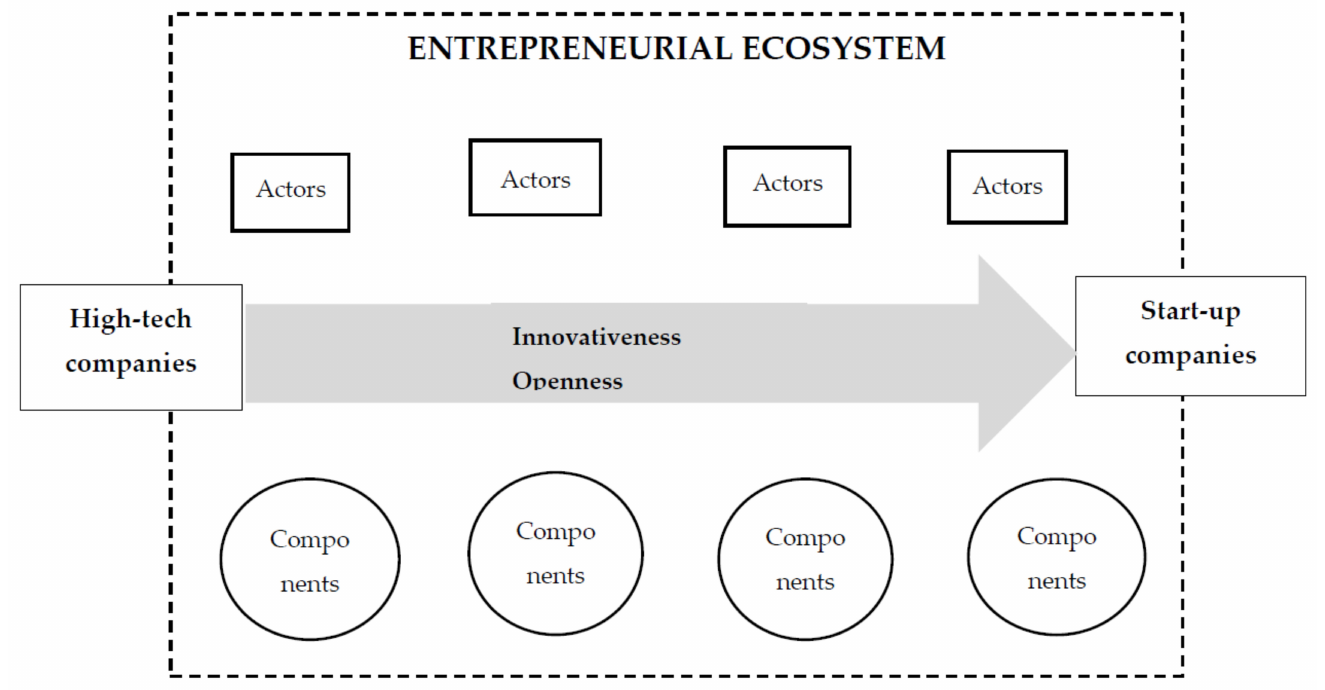
Figure 1. Conceptual model of high-tech internationalization’s influence on start-up